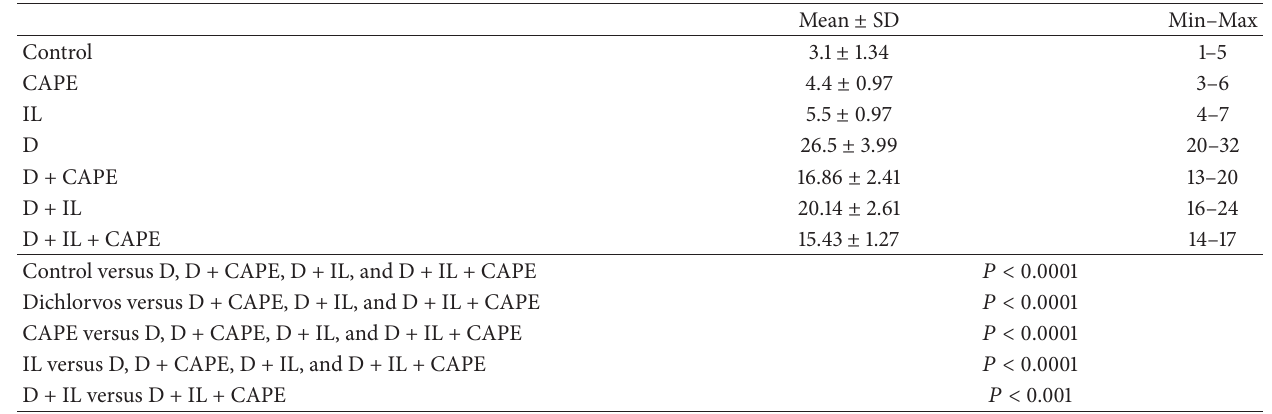
Table 2: Histopathologic results for kidney tissues, mitotic cell count.